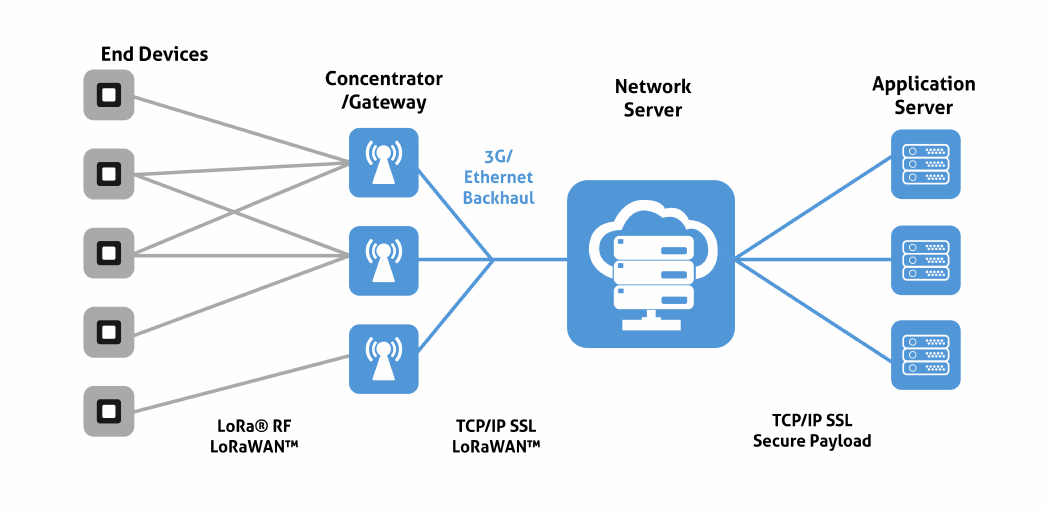
Figure 1. ThingPlug based IoT